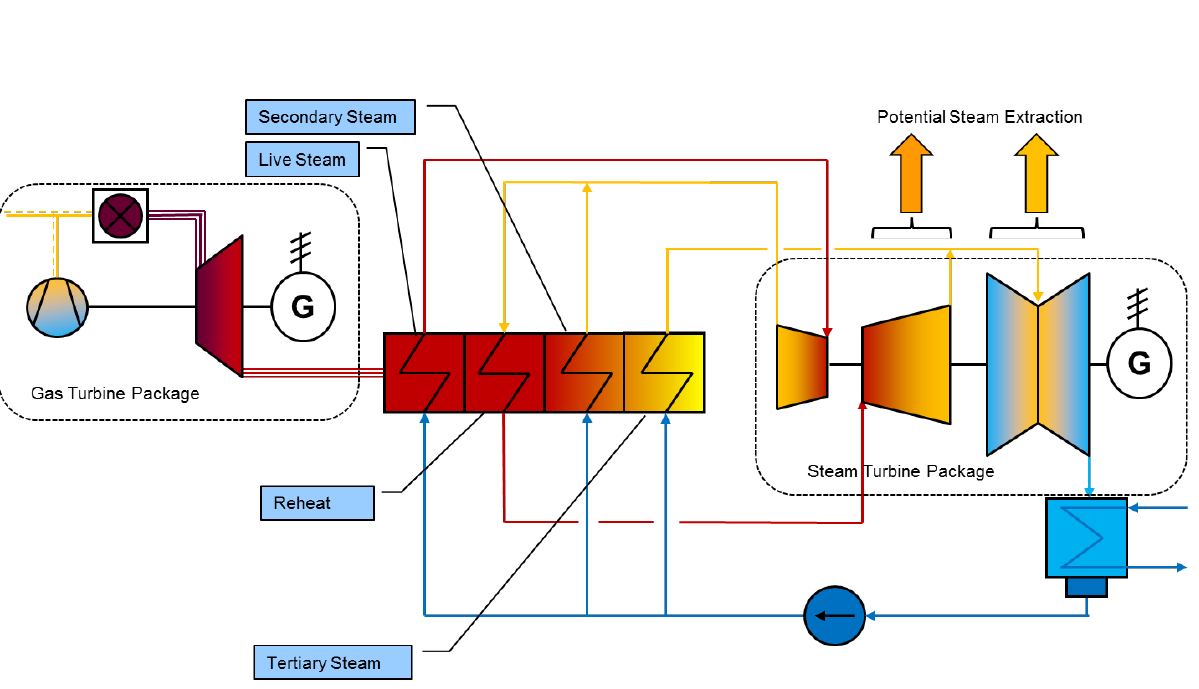
Figure 1. Triple pressure reheat cogeneration cycle (simplified).